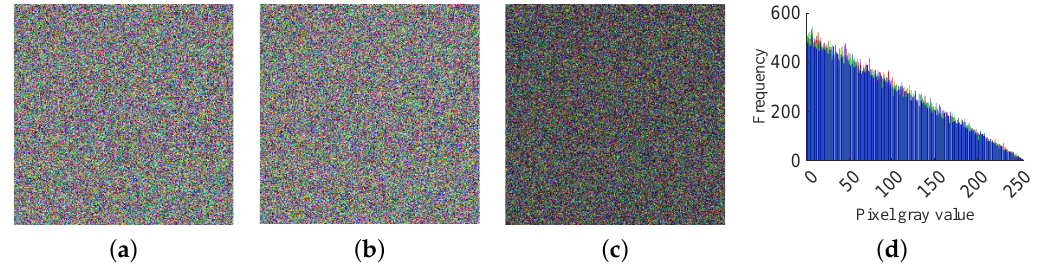
Figure 7. Chaotic sequence sensitivity: ( a ) Primal Chaos Sequence; ( b ) Chaos sequence image after change; ( c ) Chaotic sequence difference graph; ( d ) Chaotic sequence difference histogram.